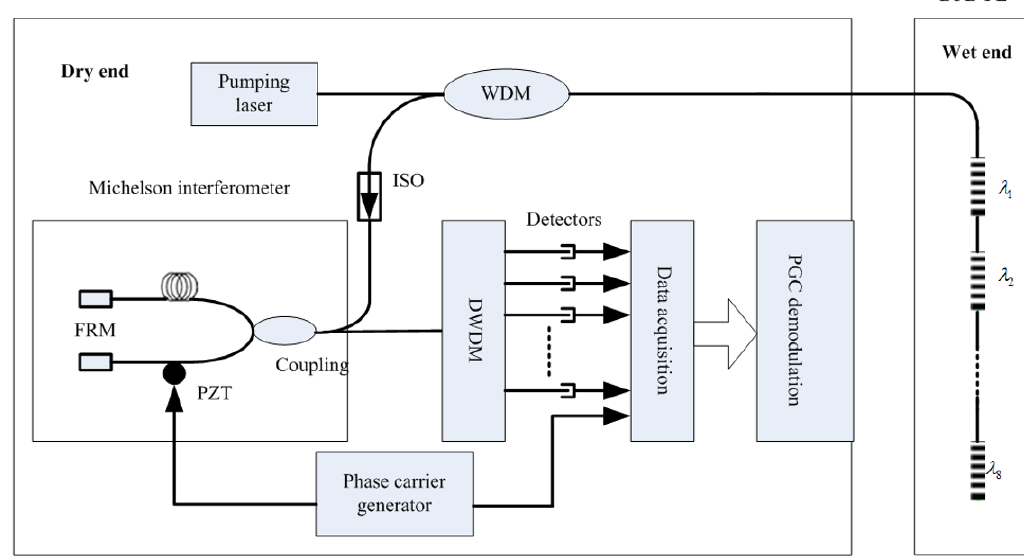
Fig. 5 Fiber laser hydrophone system schematic diagram.